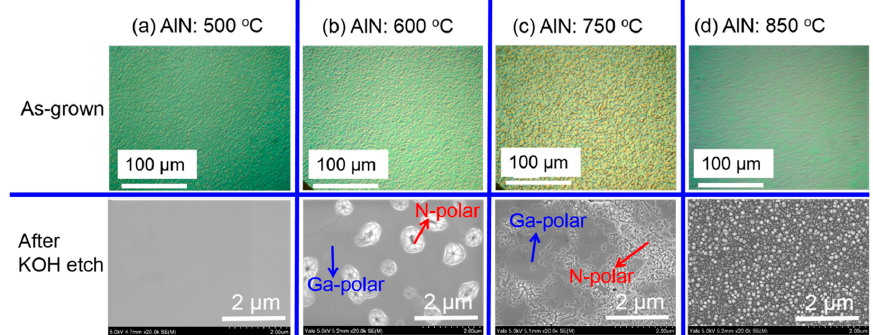
Figure 1. Optical microscope images of as-grown (top array) and SEM images (bottom array) of KOH etched GaN epilayers with AlN buffer layers grown at temperatures of ( a ) 500 °C; ( b ) 600 °C; ( c ) 750 °C; and ( d ) 850 °C, respectively.